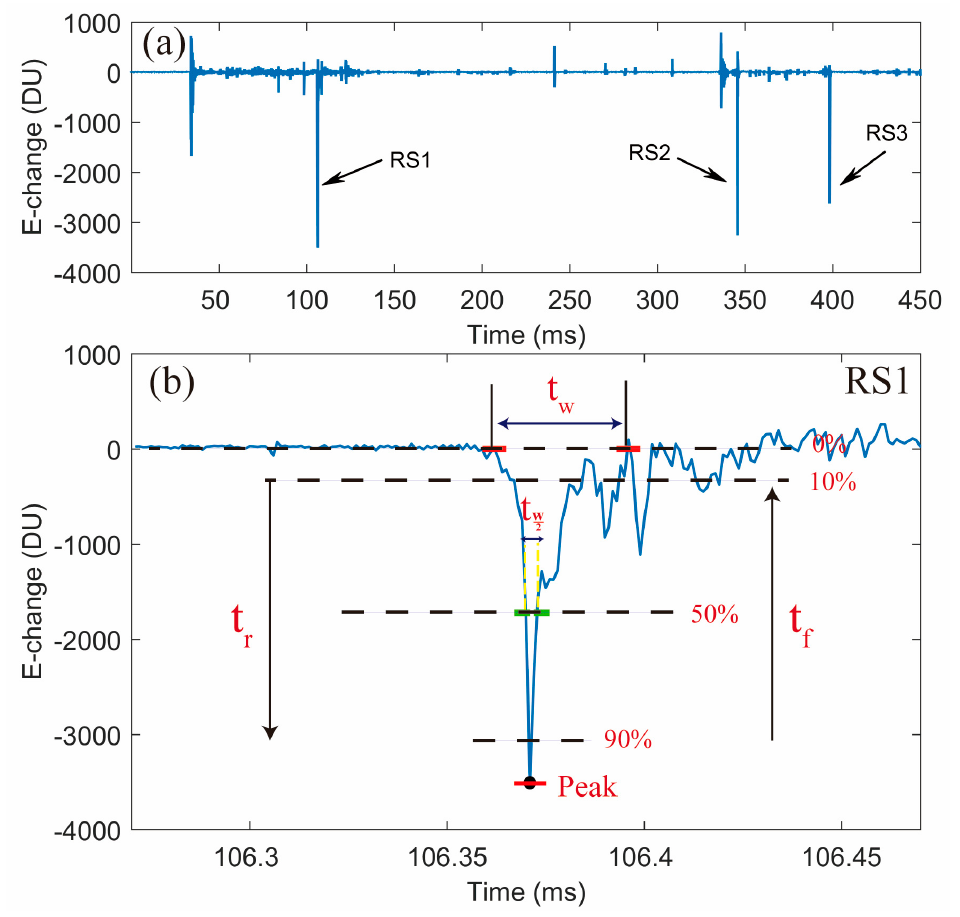
Figure 3. Illustration of calculating pulse parameters: ( a ) E-change waveform of a negative CG flash containing three negative RSs; ( b ) parameter definitions in the expanded view of the first RS. The abbreviation of DU stands for digital unit.